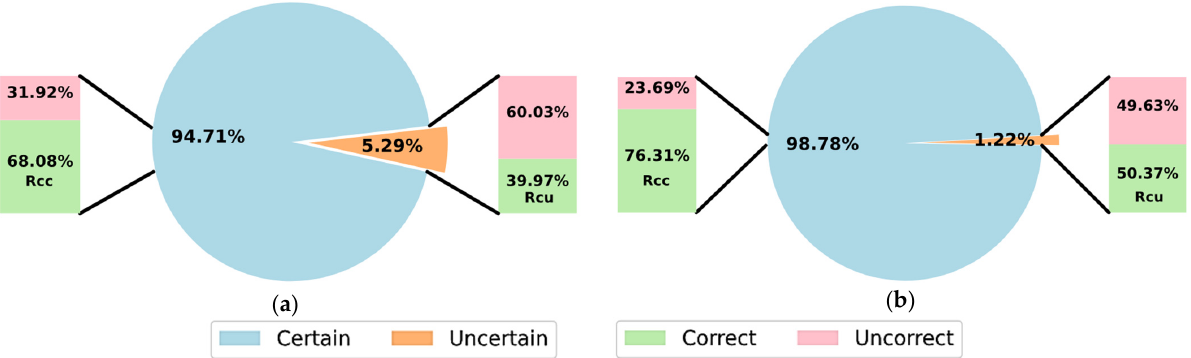
Figure 5. Results using SCNN ‐ MOPED with the adaptive threshold scheme for MI classification with reject option, considering the non ‐ subject ‐ specific strategy, ( a ) dataset 2a; ( b ) dataset 2b.